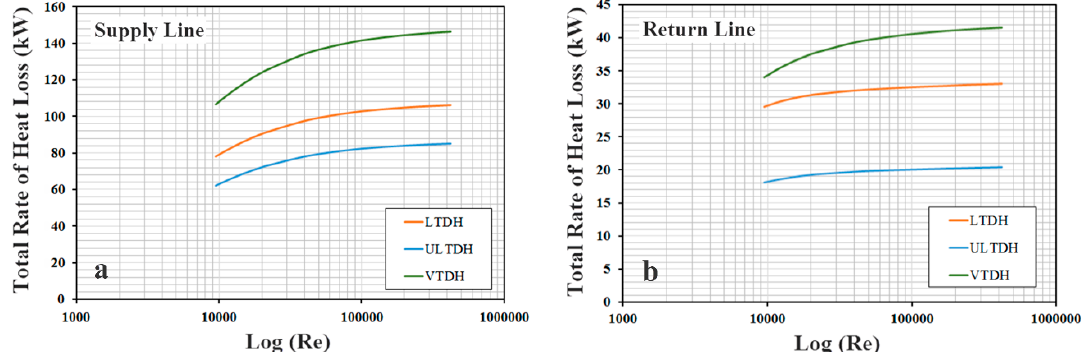
Figure 8. The effect of Reynolds number on the level of heat loss through the supply and return lines in each case. ( a ) supply lines; ( b ) return lines.